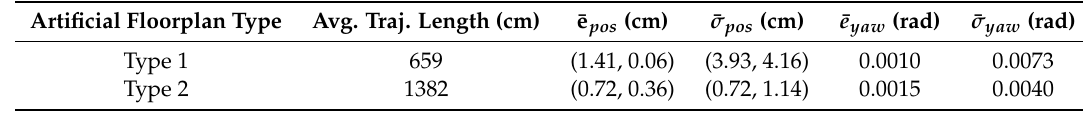
Table 2. Synthetic testing results.